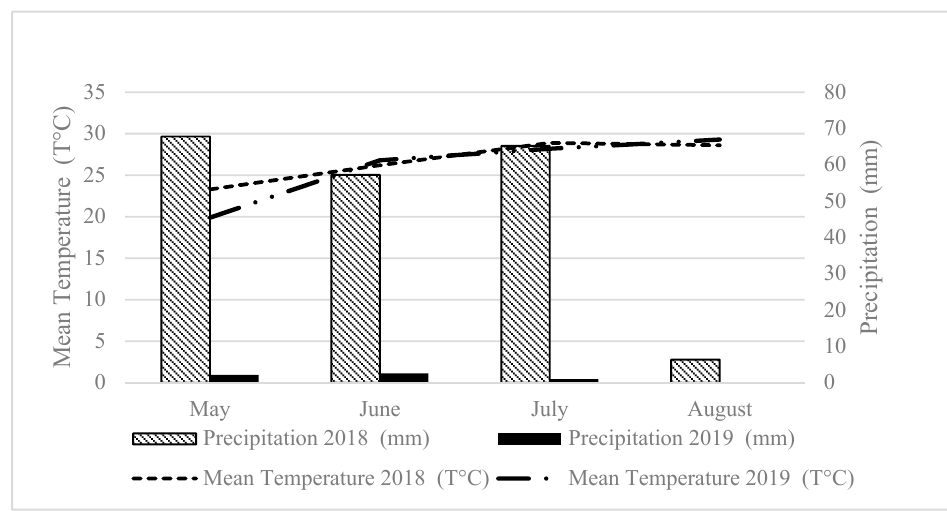
Figure 1. Meteorological data at experimental area for the growing seasons 2018 and 2019. The total precipitation was 196.6 mm in 2018, and 5.8 mm in 2019.